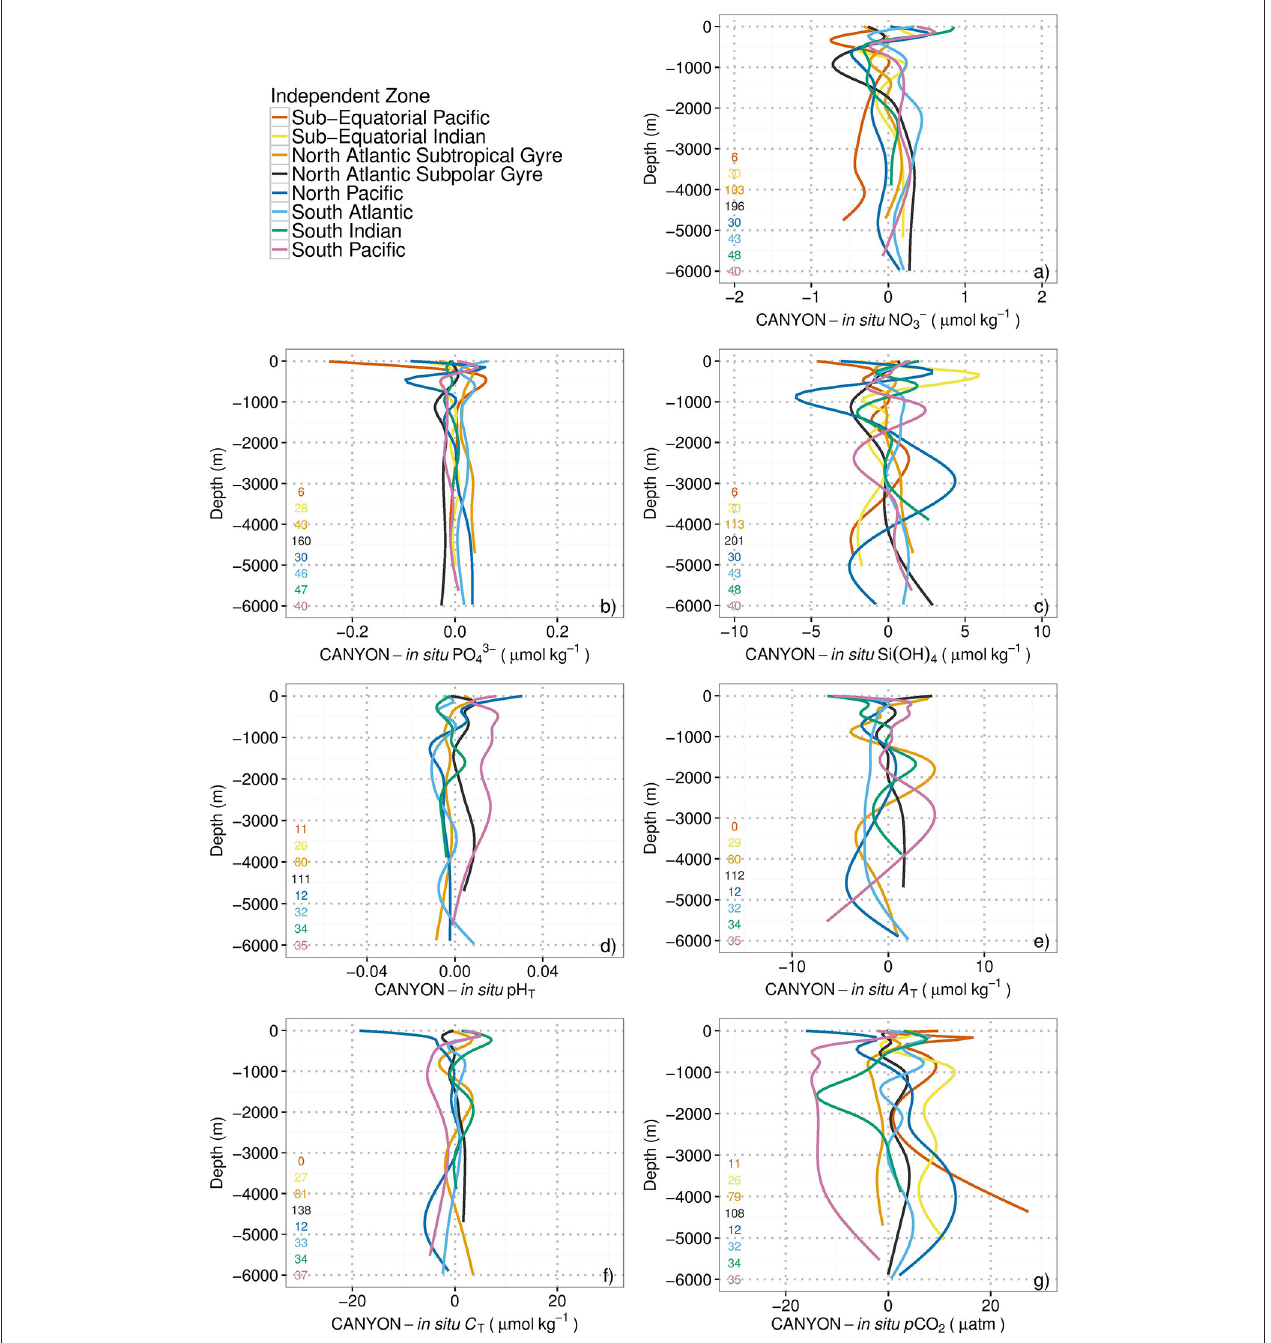
FIGURE 6 | Vertical profiles of the smoothed mean differences between CANYON-retrieved and in situ measurements from surface to 6,000m depth for: (a) NO 3 − ; (b) PO 43 − ; (c) Si(OH) 4 ; (d) pH T ; (e) A T ; (f) C T ; and (g) p CO 2 . The number of profiles used to compute the mean difference for each zone is indicated in the bottom left-hand side of each panel. Color code: eight independent zones in Figure 1